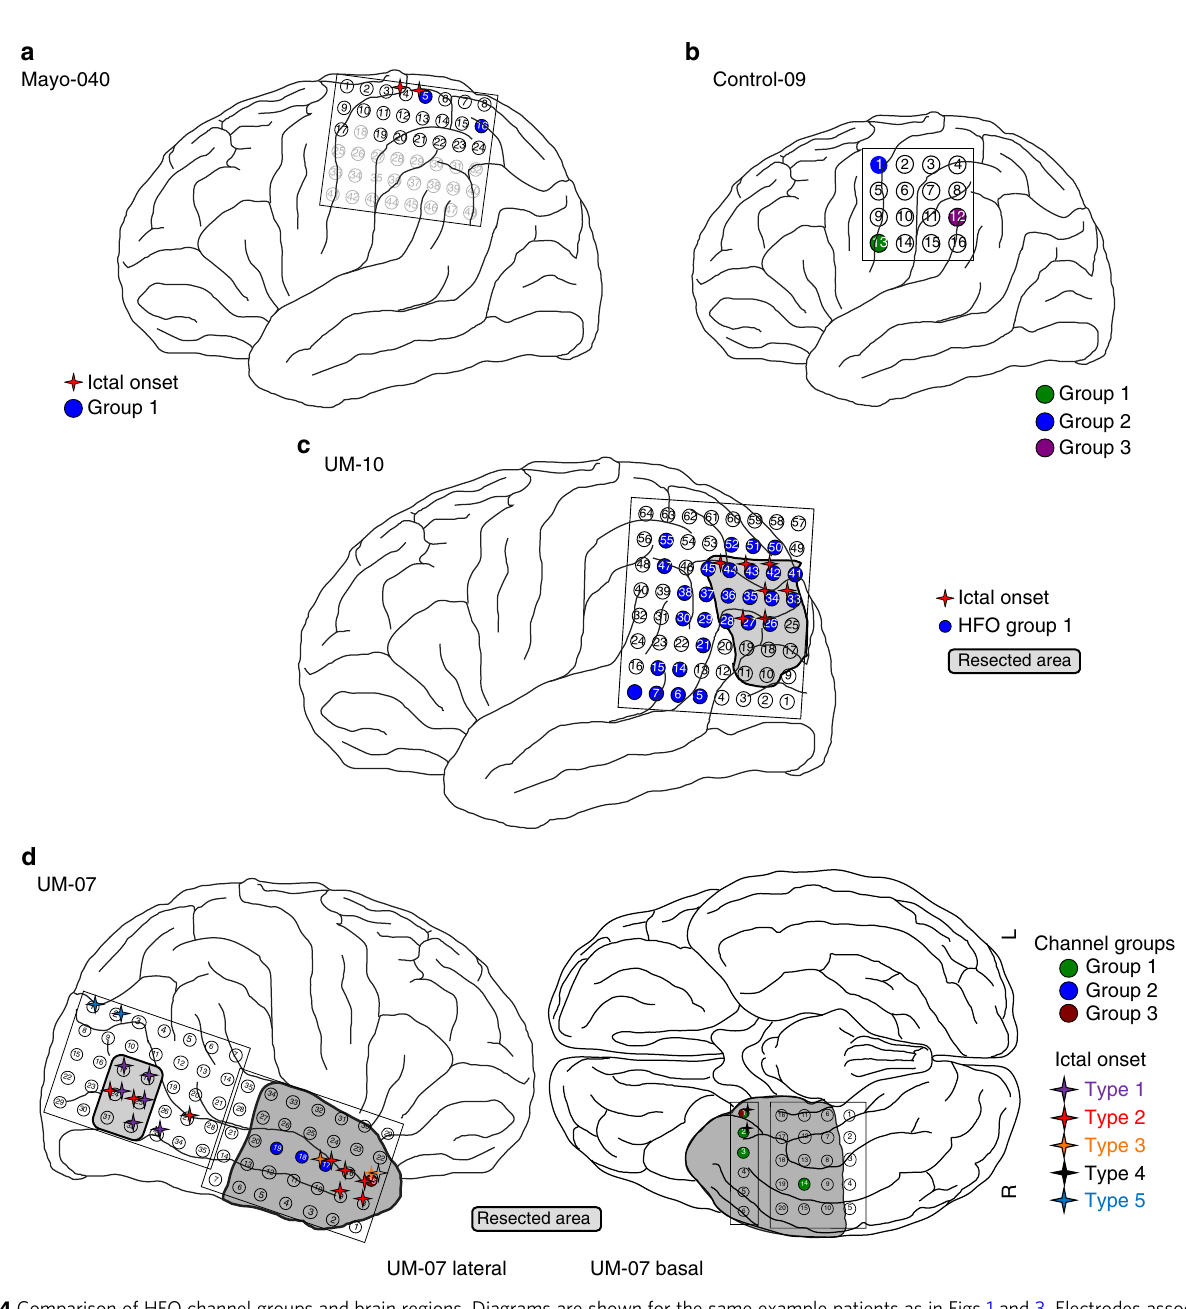
Fig. 4 Comparison of HFO channel groups and brain regions. Diagrams are shown for the same example patients as in Figs 1 and 3. Electrodes associated with speci fi c channel groups (white stars in Fig. 3) are color coded by group number, and seizure onset electrodes are denoted by colored stars adjacent to the electrode. In c , a lesion (not shown) was found under channels 27, 28, 35, and 36. Note, the patients in a and b did not have resections, but both c and d did and have had class I outcomes for >3 years. Data were not available for grayed out electrodes in